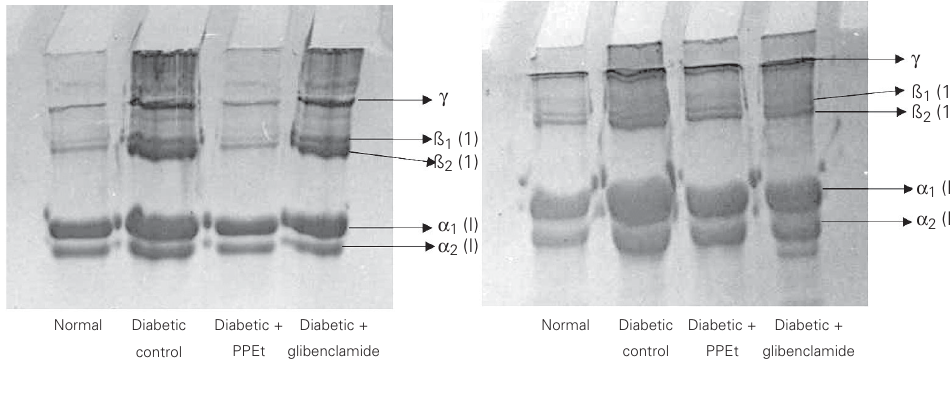
Figure 1. Effect of Phaseolus vulgaris pod extract (PPEt) on SDS-PAGE pattern of acid- soluble (left) and pepsin-soluble (right) collagen of tail tendon in normal and diabetic rats.